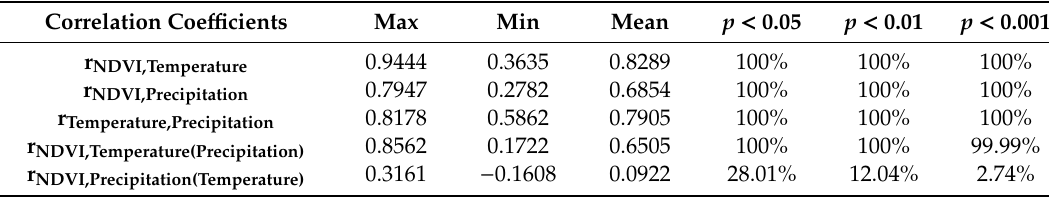
Table 5. Correlation coe ffi